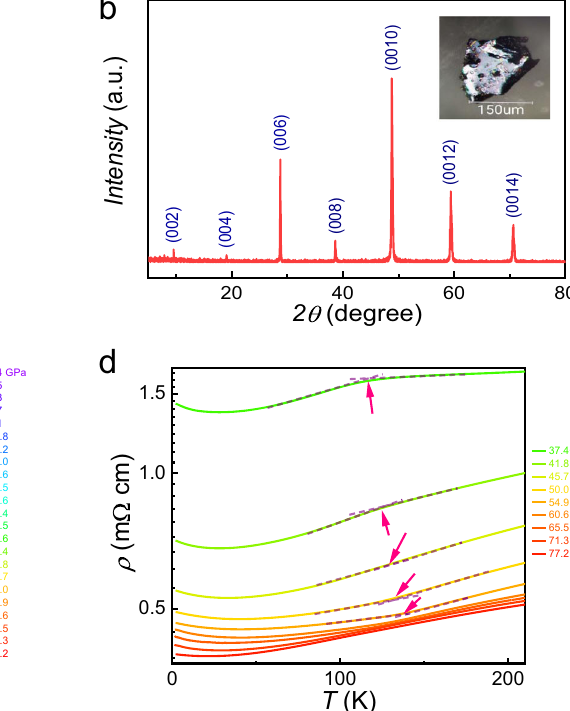
transition occurs near 40GPa. d Enlarged area of the temperature dependence of resistivity for La 2 O 3 Fe 2 Se 2 single crystal when entering the metallic state. The pink arrows indicate the kinks in the resistivity curves which is possibly related to the ferromagnetic